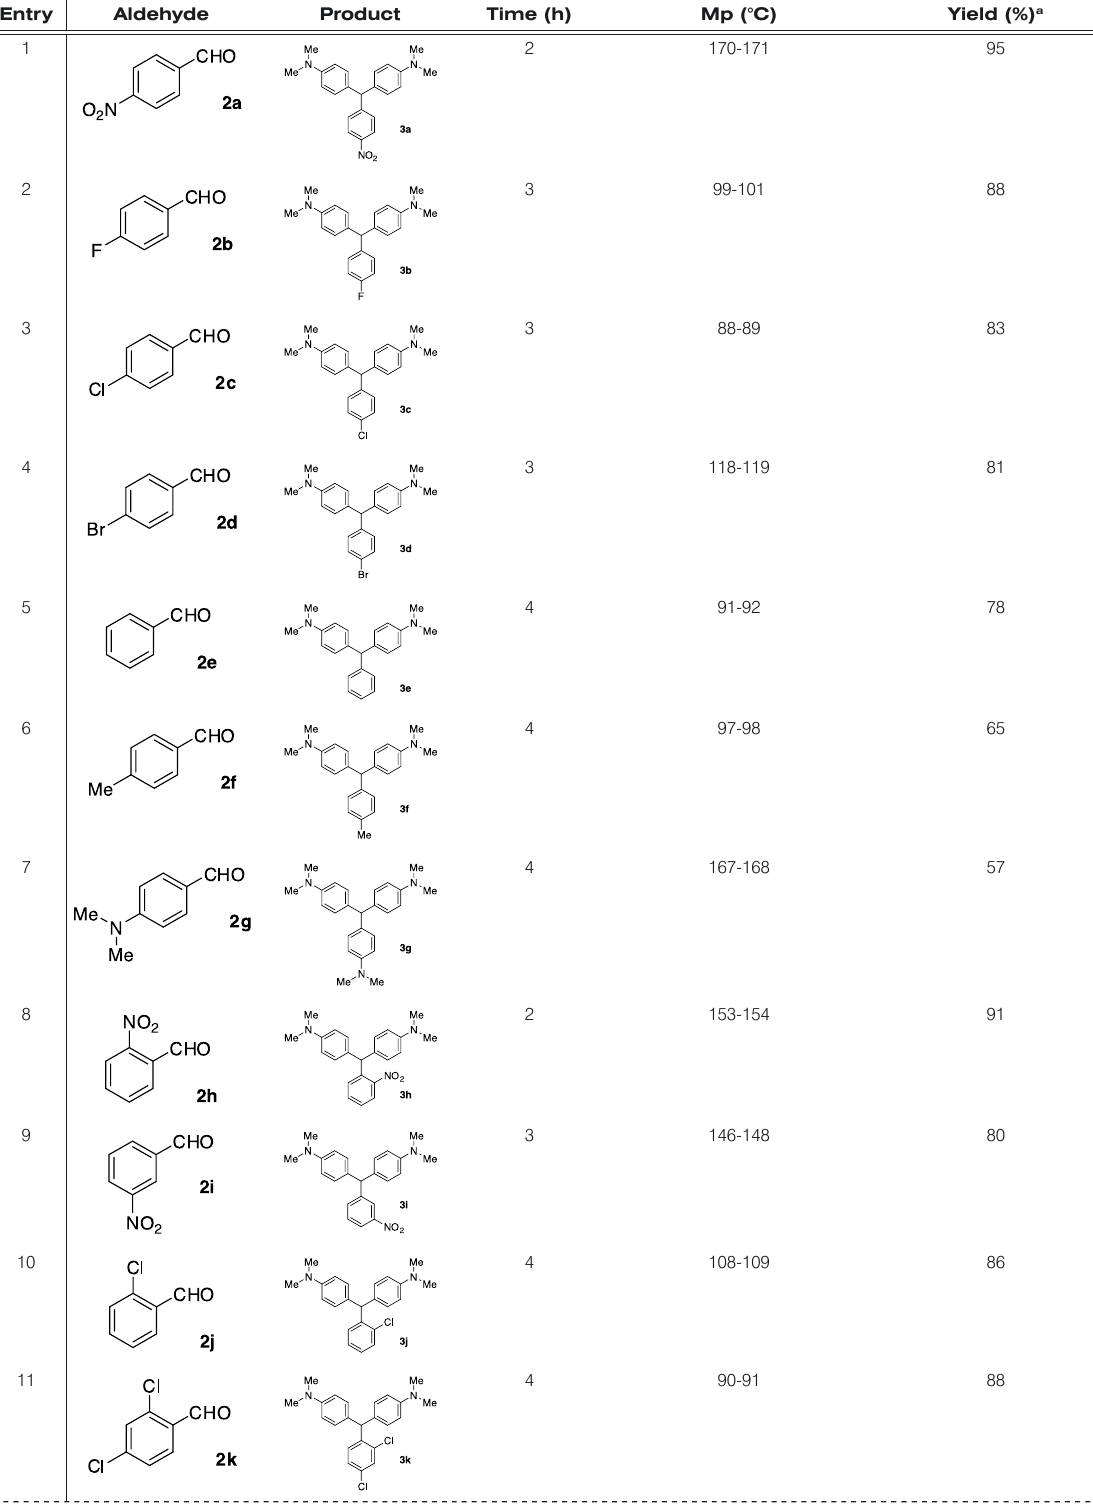
Table 1. Synthesis of 4,4’-diaminotriarylmethanes